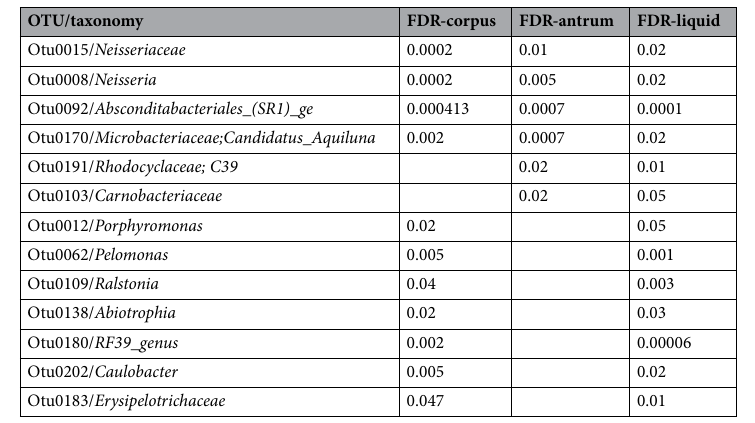
Table 3. Operational taxonomic units (OTUs) showing differential abundance between H. pylori -negative control subjects and CD patients at more than one gastric site in metagenomeSeq